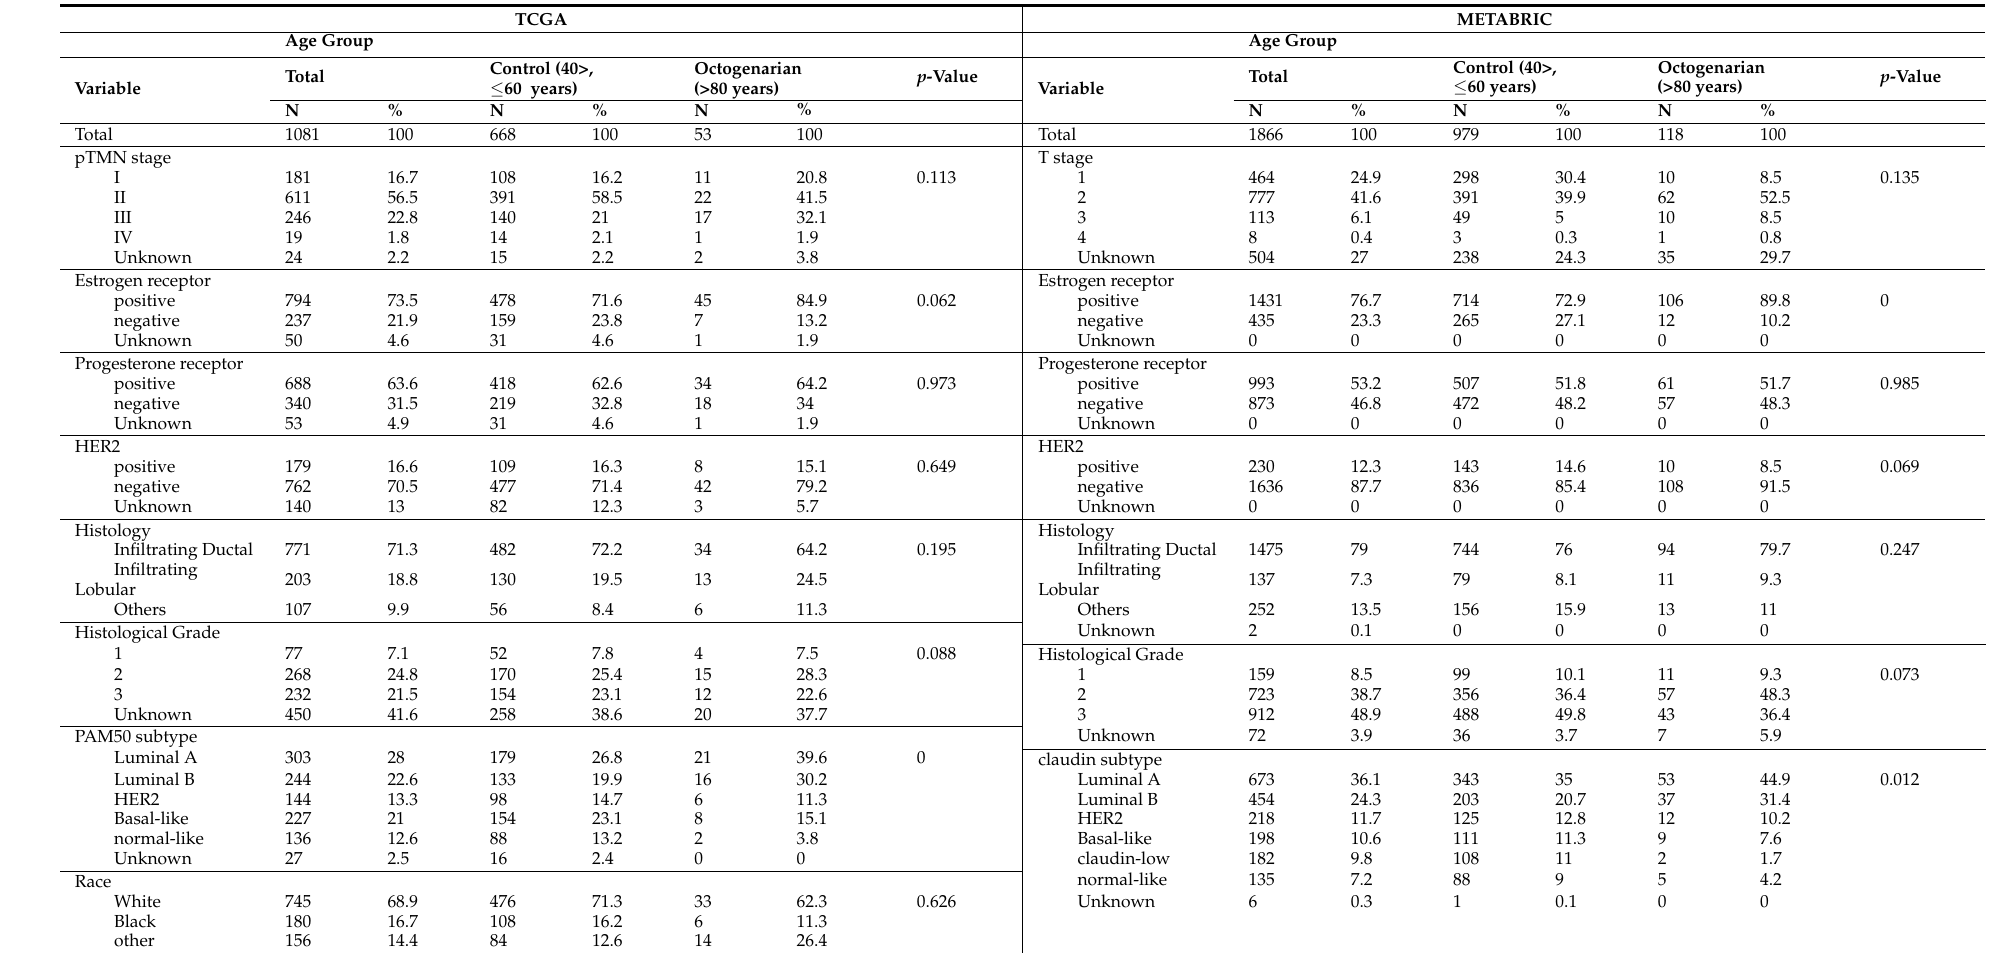
Table 1. Clinical factors of the each patient